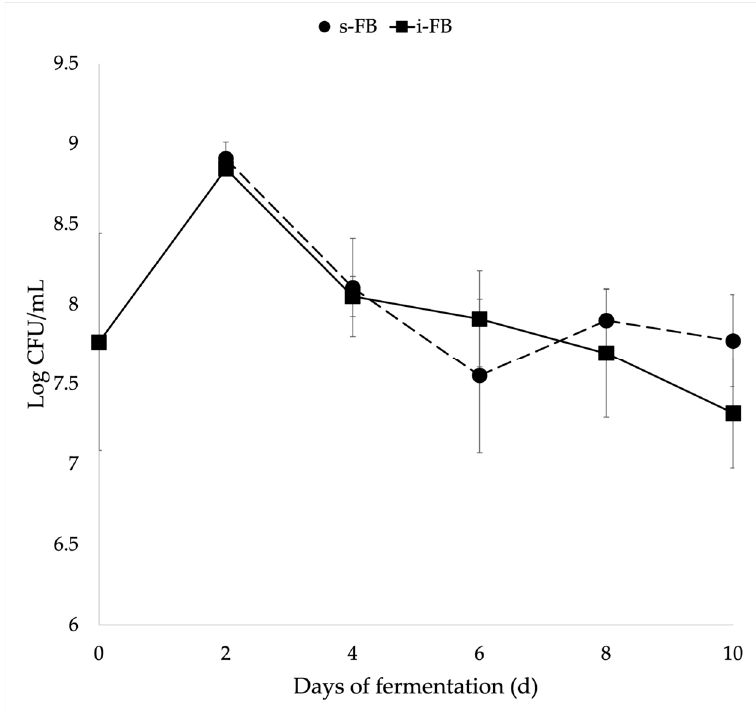
Figure 1. Changes in the microbial growth during the fermentation of broccoli. s-FB: spontaneous fermentation; i-FB: induced fermentation. Error bars represent standard deviations of the means.